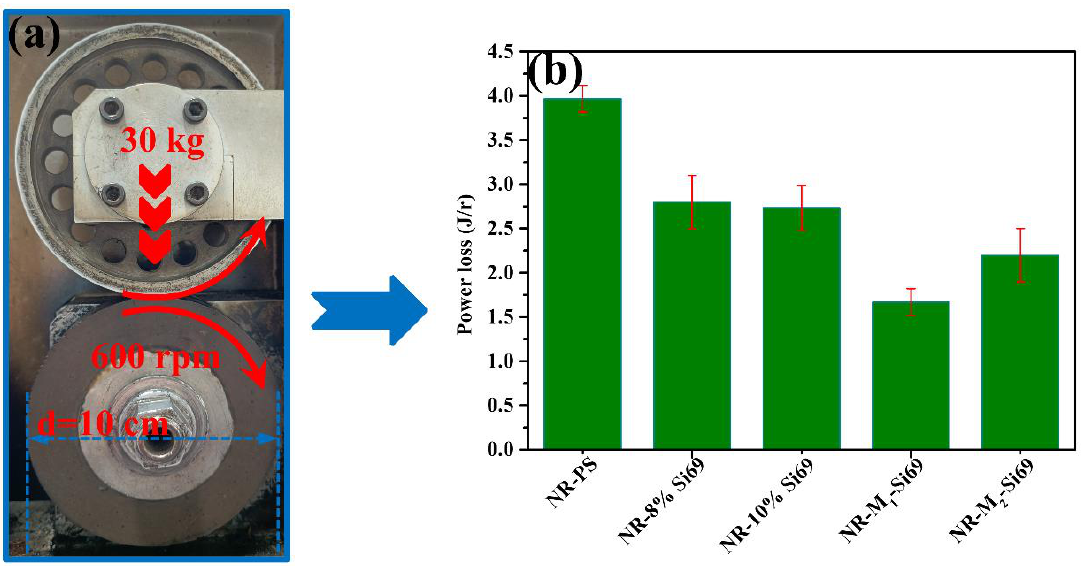
Figure 12. ( a ) Model of the tire energy loss test; ( b ) energy loss.